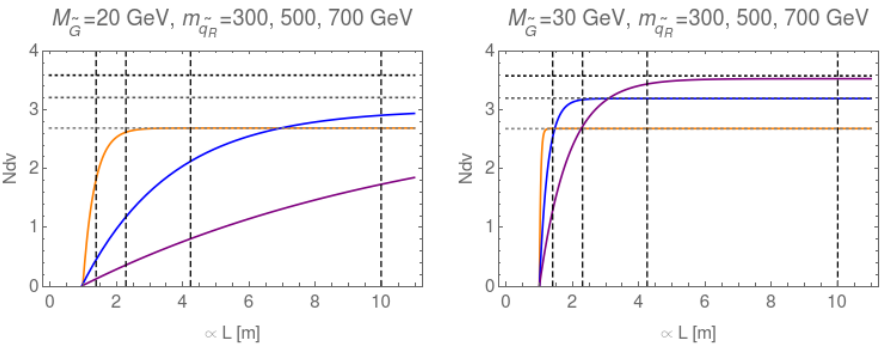
Figure 6 . Distribution of displaced vertices for m ~ q = 300 ; 500 and 700 GeV, and M ~ The vertical axis, Ndv is the number of displaced vertices as a function of distance L from the primary, normalized by r ~ , the f-gluon fragmentation fraction into the 0 ++ glueball. The vertical G 0 lines indicate approximate boundaries of the inner tracker, electromagnetic calorimeter, hadronic calorimeter and muon system of the ATLAS detector. The horizontal dotted lines correspond to the average multiplicity for each of the three cases for the squark masses, from bottom to top: 300 GeV, 500 GeV and 700 GeV.